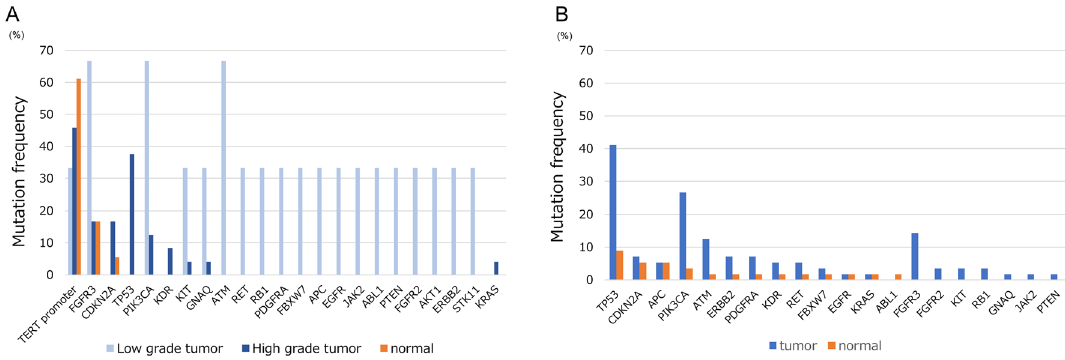
Figure 3. Mutation frequency detected in tumor and normal urothelium. Mutation frequency of tumor samples (blue or light blue), and normal urothelium (orange) were shown. ( A ) Samples from patients with low- grade and high-grade non-muscle invasive bladder cancer. ( B ) Sample from patients with high-grade muscle invasive bladder cancer.